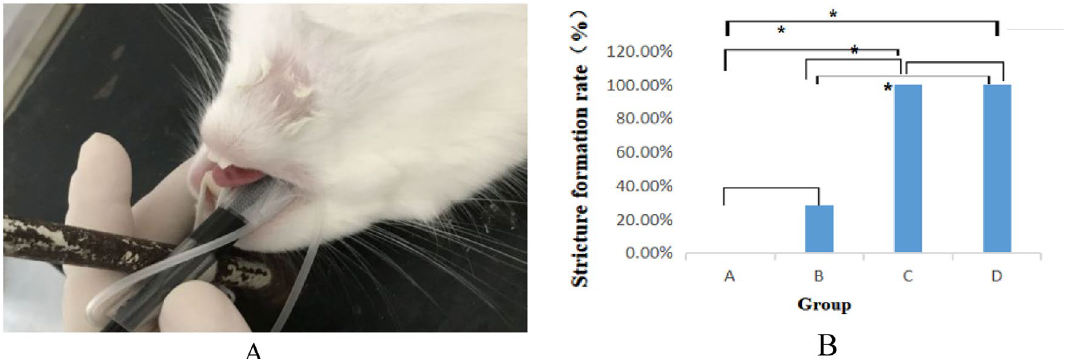
Figure 1. ( A ) Tracheal intubation in a rabbit; ( B ) comparison of the incidence of stenosis. * p < 0.05,using Fisher’s exact